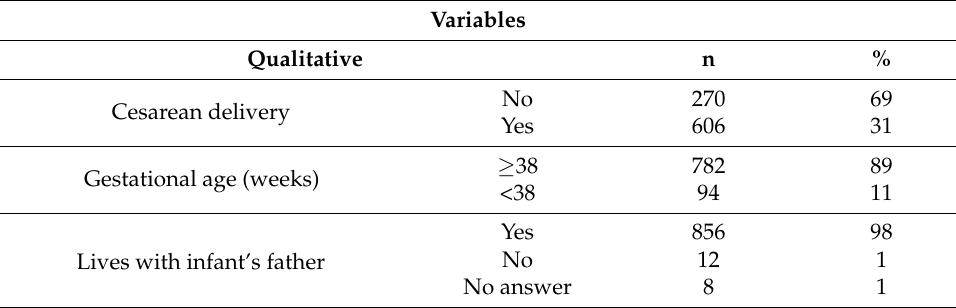
Table 2. Descriptive statistics of HAPPY MAMA web-based survey’